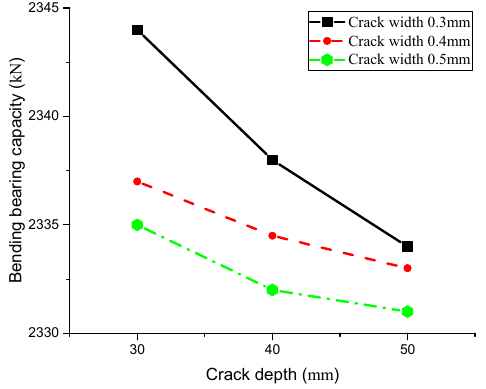
Figure 8. Curve of crack depth and bending capacity.